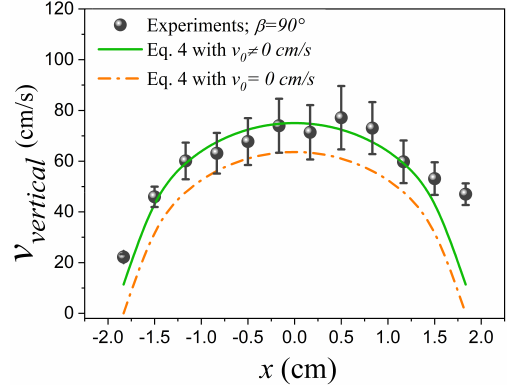
Figure 4. Velocity vs. x at the hopper outlet for lentil seeds, β = 90 ◦ and D = 4